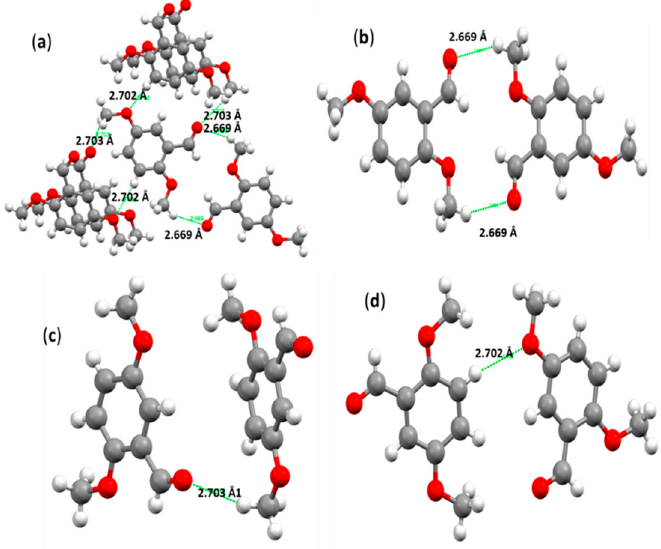
Figure 5. ( a ) Six hydrogen bond interactions determined in the crystal lattice of exo -2,5- dimethoxybenzaldehyde molecules. ( b ) C = O ··· H Me : 2.669 Å, ( c ) C = O ··· H Me : 2.703 Å, and ( d ) MeO ··· H ph : 2.702 Å.